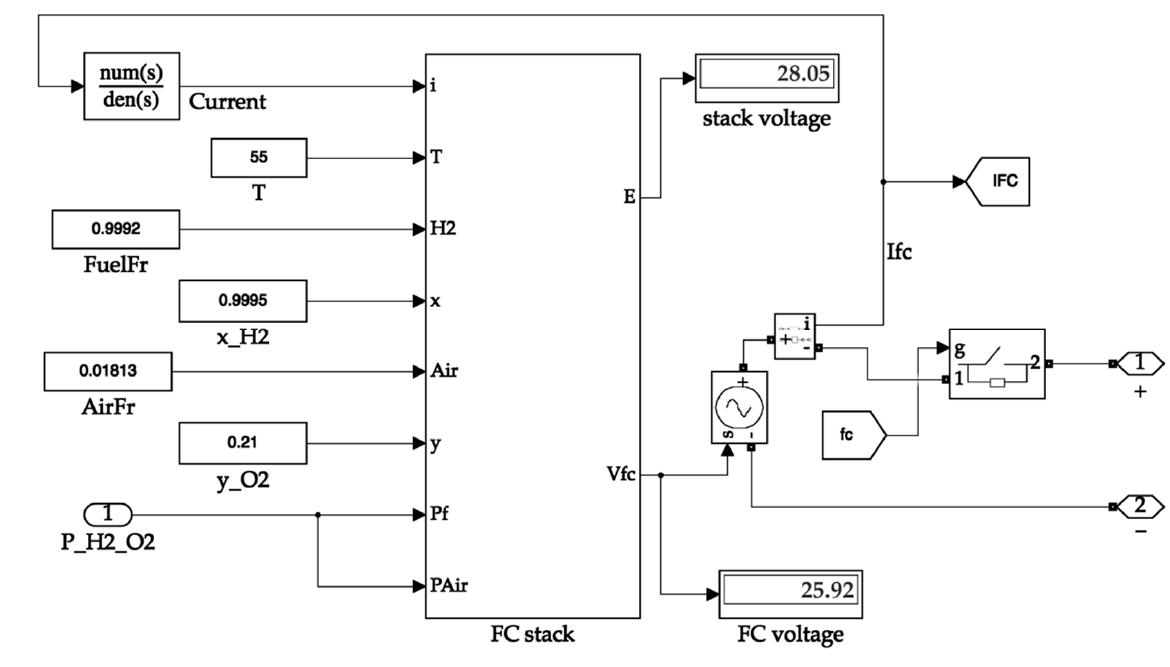
Figure 10. Fuel cell system.